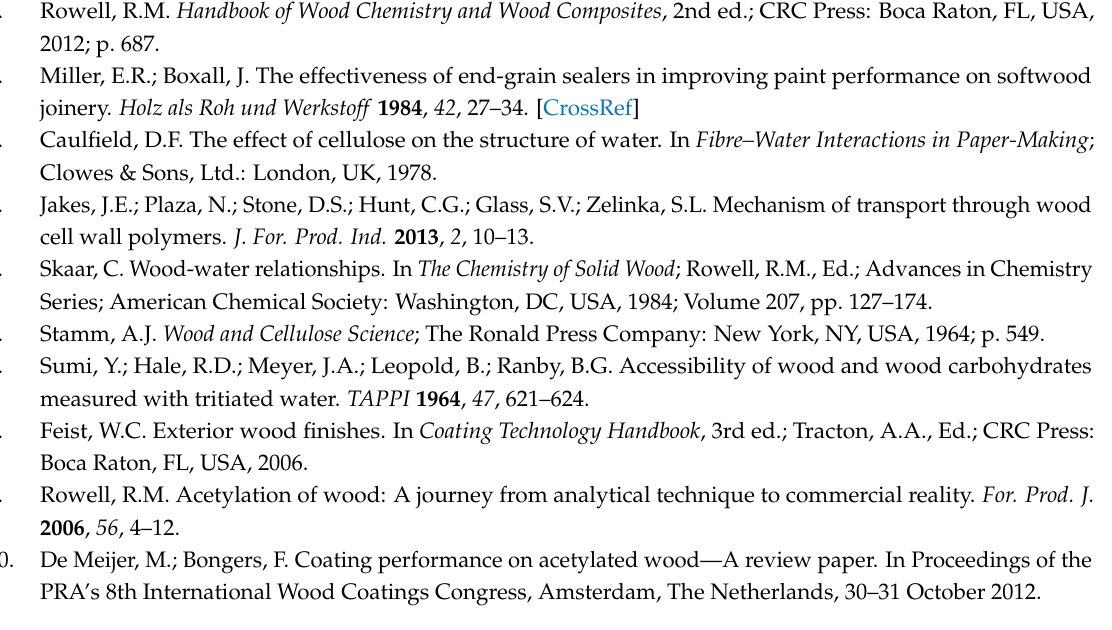
Figure 13. Opaque white alkyd coated control ( a ) and acetylated ( b ) after 9.5 years [11,12].